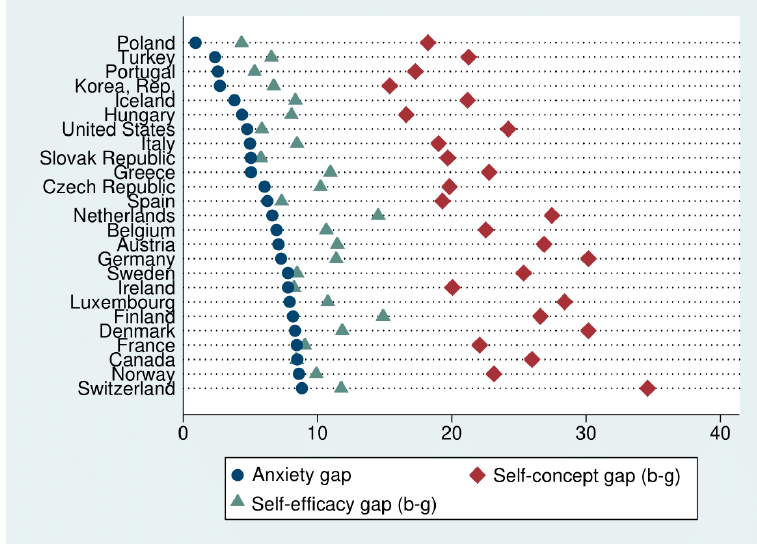
Figure 5. Gender Gaps in Self ‐ reported Math Beliefs.